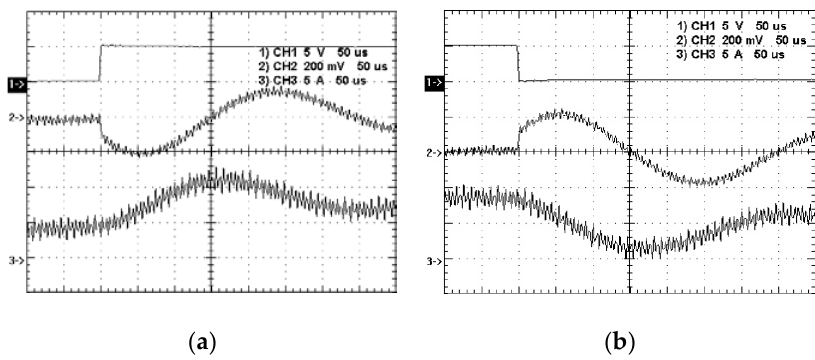
Figure 17. Zoom-in waveforms based on the traditional PWM control strategy: (1) load enable; (2) AC output voltage; (3) inductor current, due to ( a ) from 50% to 100%; ( b ) from 100% to 50%.